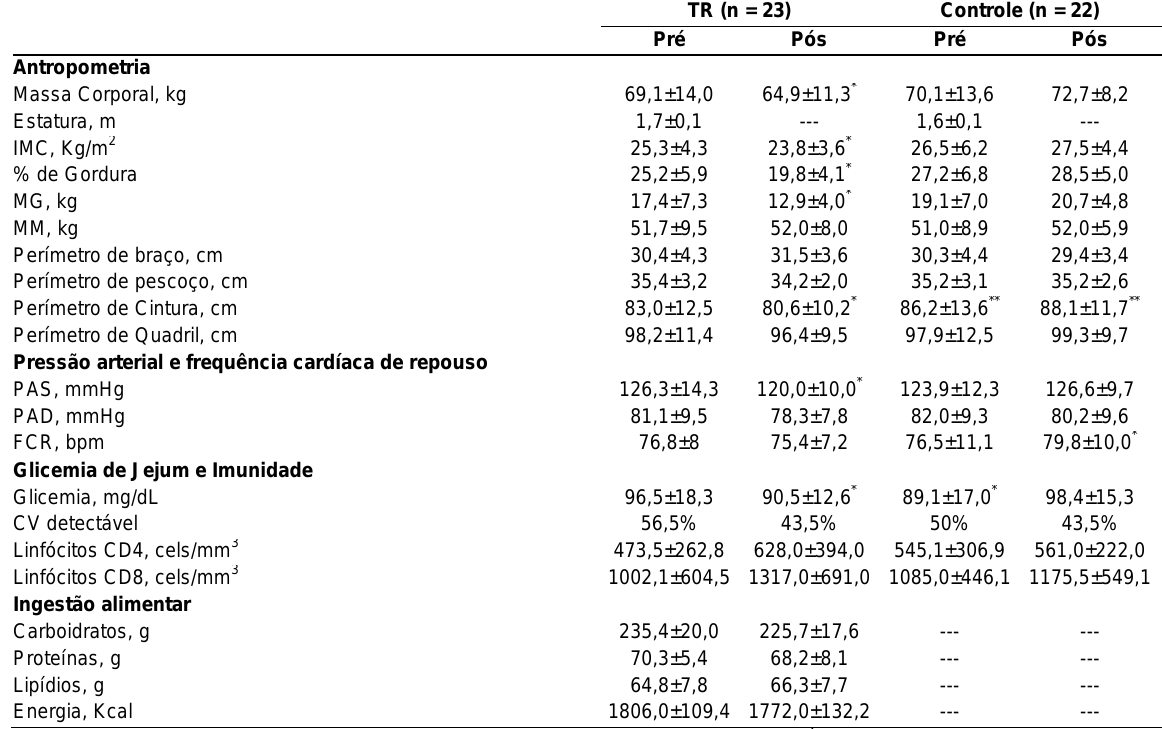
Tabela 2. Medidas antropométricas, composição corporal, metabólicas, imunitárias e ingestão alimentar para os grupos TR e